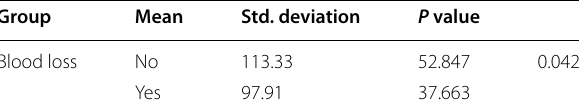
Table 3 Blood loss